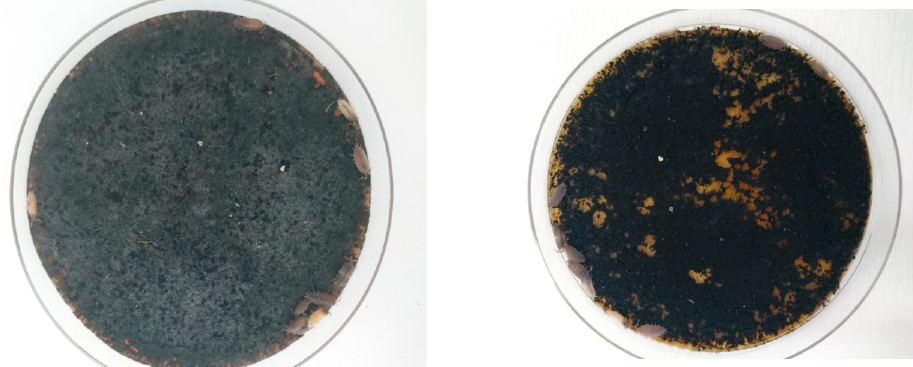
Figure 3. Machrophomina phaseolina mycelial loss in two weeks (Photo: Nóra Balázs, Gödöll ő , Hun- gary, 2016).